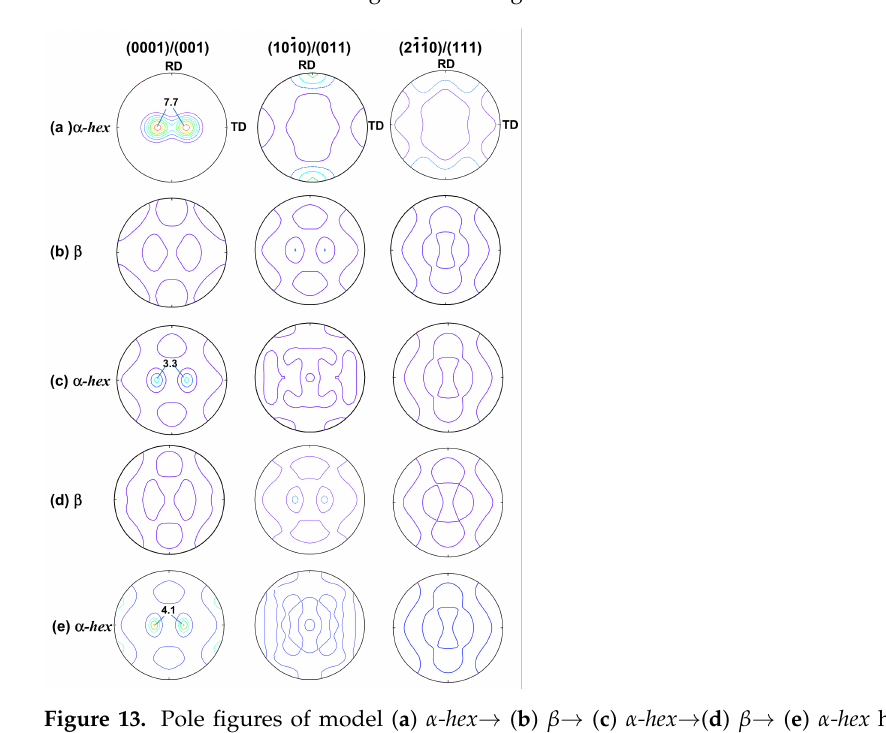
Figure 12. Pole figures of predicted ( a ) β and ( b ) α -hex textures in the second heating cycle based on the observed texture shown in Figures 3c and 4g–i.